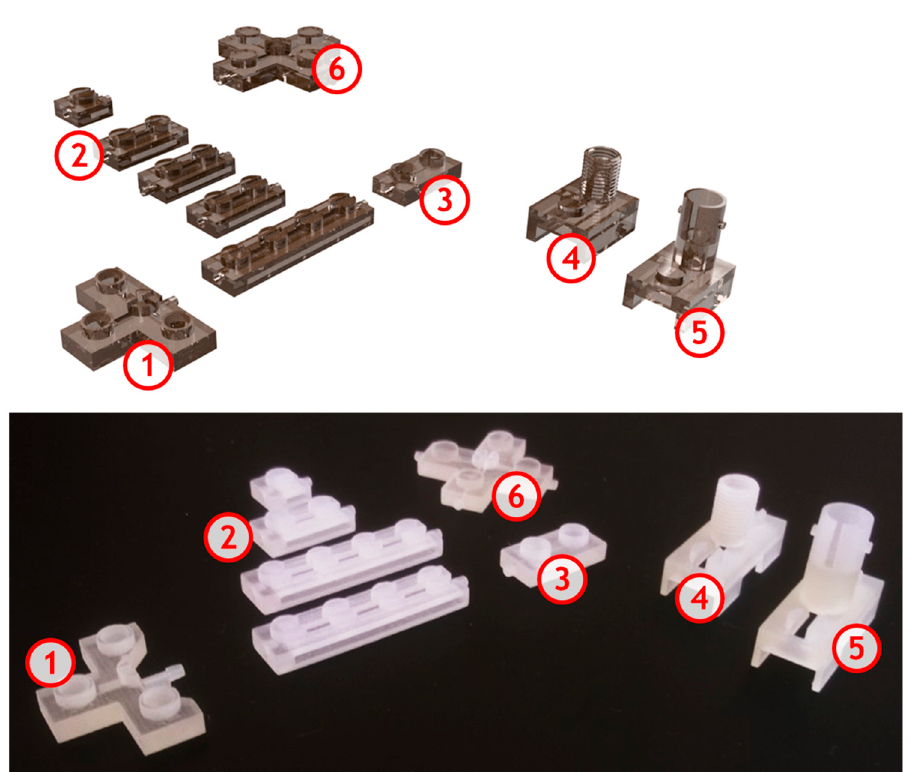
Figure 1. 3D printed microfluidic modules for on-chip gel electrophoresis – visualization and view of printed modules: 1—T-type injector; 2—separation microchannels with various lengths; 3—final module; 4,5—optical detection modules with SMA/ST optical fibre connections,